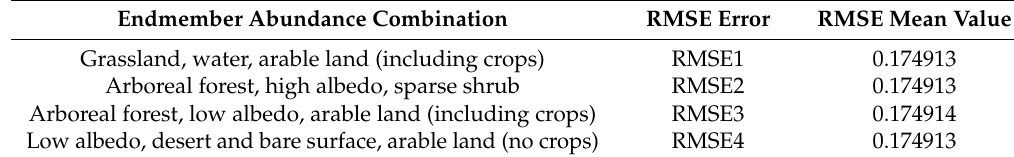
Table 7. Root Mean Square Error (RMSE) error.